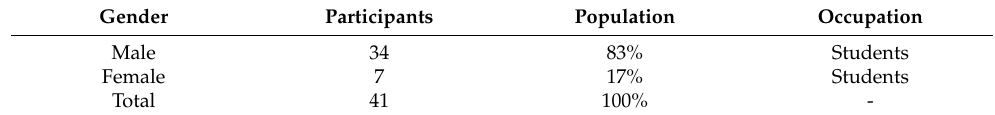
Table 6. Description of focus group demographics.